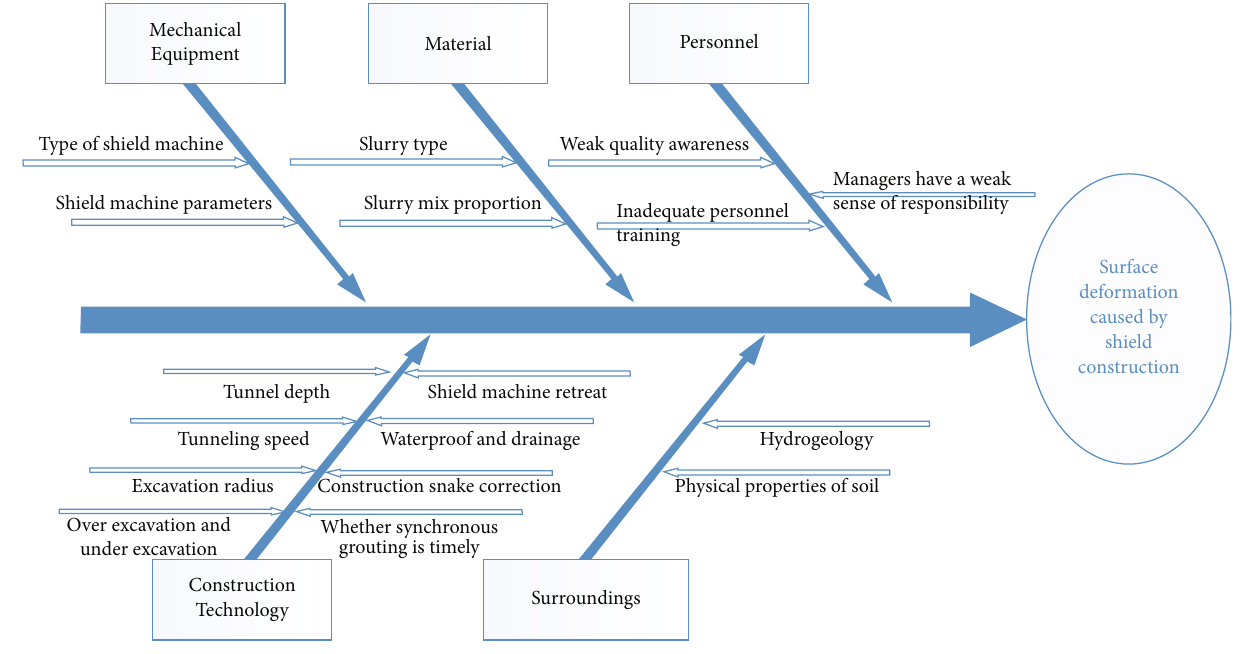
Figure 3: Analysis of surface deformation fi shthorn method.